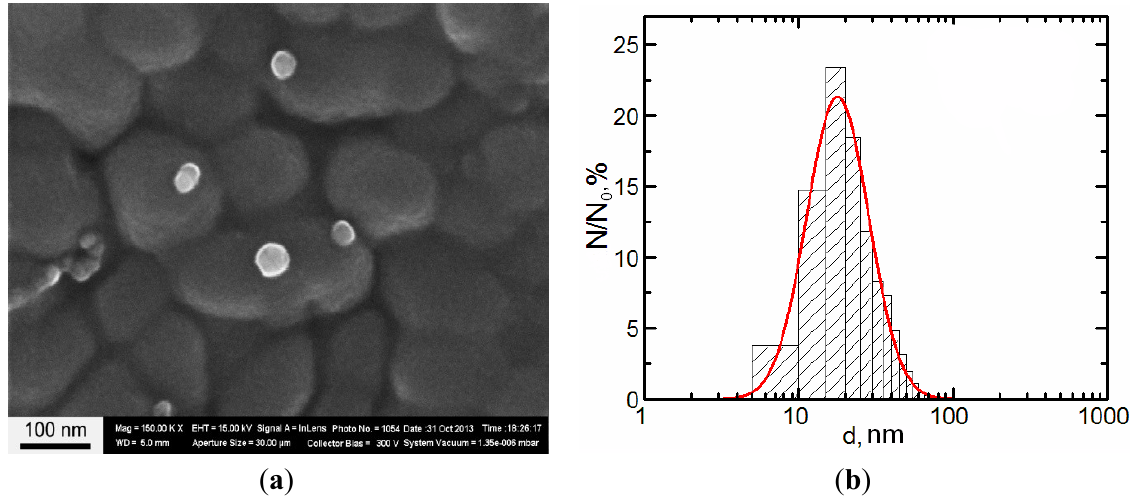
—total number of 0